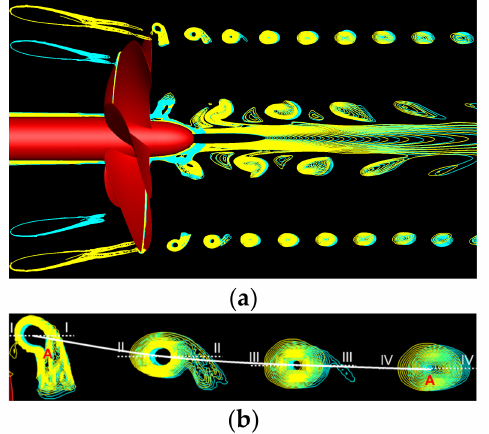
Figure 17. Superposed contours of vorticity drawn in the D N / D = 0.7 and D N / D = 1 computa- tional cases. Attack angle θ = 10 ◦ : ( a ) wake global view; ( b ) close-up view.